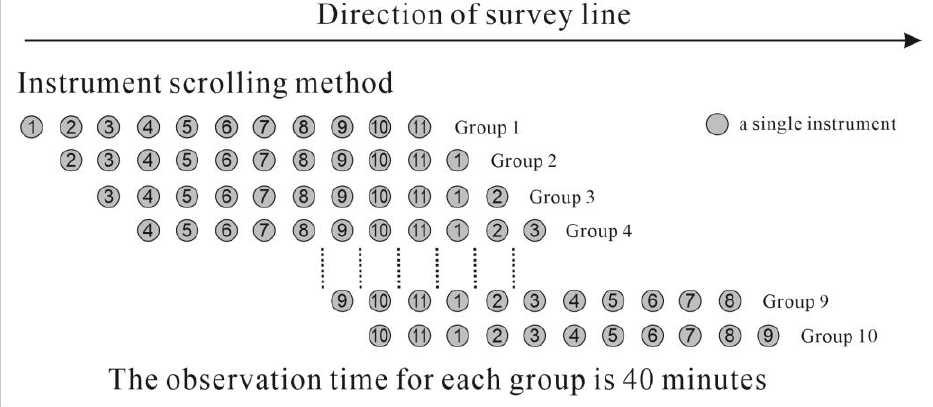
Figure 7. Schematic diagram of instrument rolling.